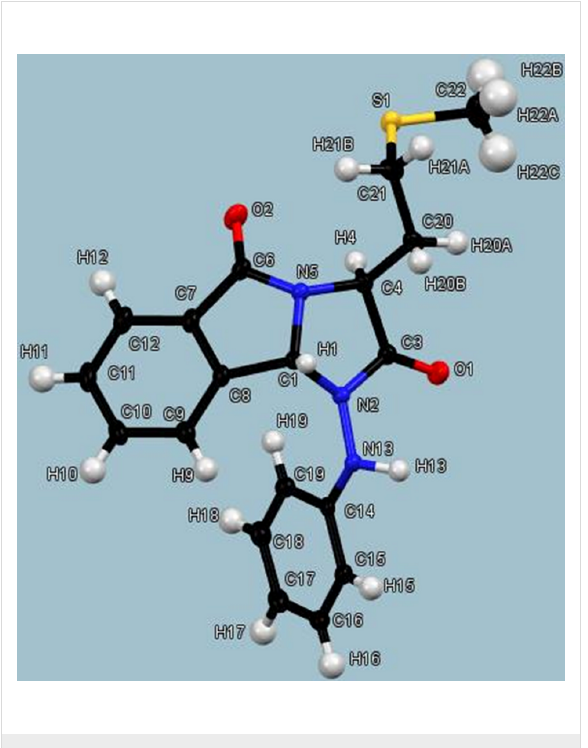
Figure 3: X-ray crystal structure of 5f shown at the 30% probability level.